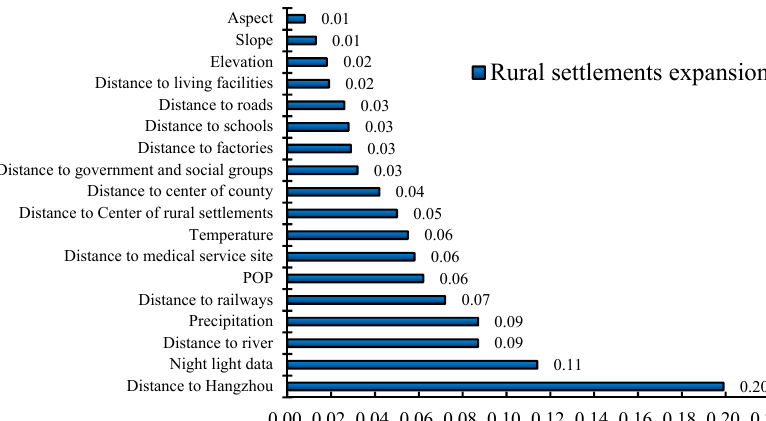
Figure 12. Contribution of each factor to rural settlement expansion.